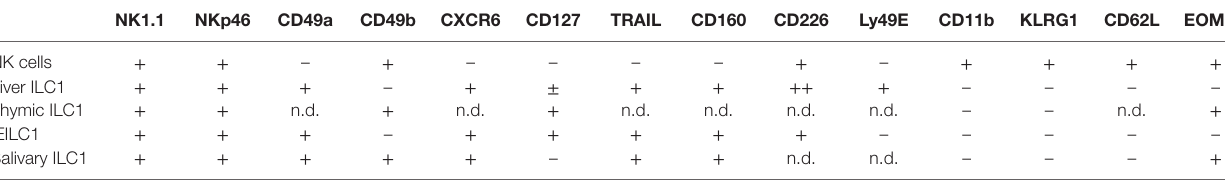
TABLe 1 | Phenotype of NK cells and tissue-specific